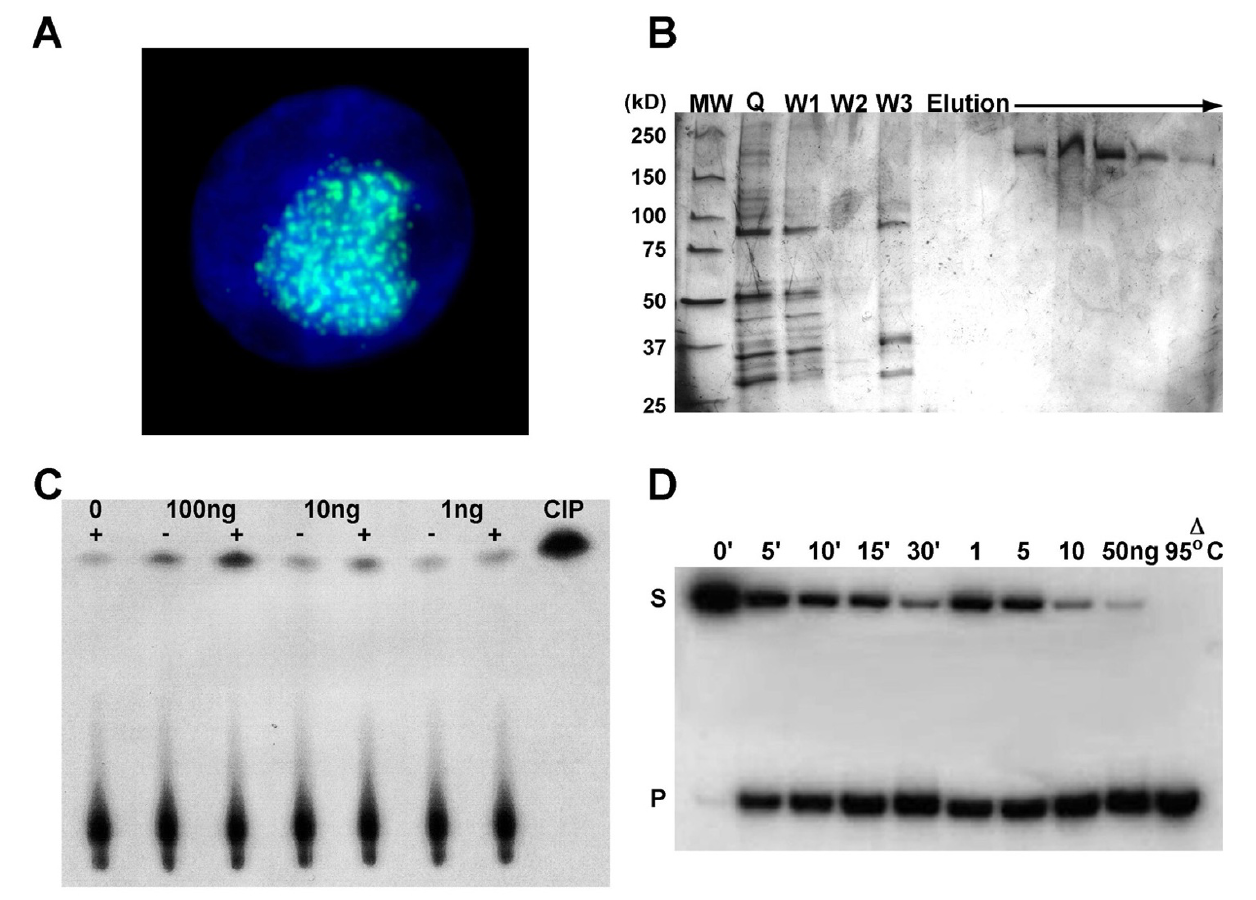
Figure 1 Purification and Assay of GFP-BLM. A. Fluorescent microscope image of GFP-BLM in the DAPI-stained nucleus of an Sf9 cell 72 hours after infection with a recombinant baculovirus. GFP-BLM forms large green aggregates. B. Silver-stained SDS 4- 12% polyacrylamide gel of the purification of GFP-BLM using Macroprep Q ion exchange chromatography followed by metal chelate resin chromatography. Lane Q shows the ion exchange column pool of the green GFP-BLM fractions and lanes W1- W3 are proteins eluted from the metal resin with increasing imidazole washes (wash1 = 10 mM, wash2 = 50 mM, wash3 = 100 mM). The elution lanes show purified GFP-BLM eluted with a final step of 200 mM imidazole. The molecular weights (MW) of the standard markers (BioRad Precision) are indicated. C. Autoradiogram of a thin-layer plate ATPase assay of GFP-BLM. The amount of protein in the assay is shown. The addition of single-stranded Mpl8 DNA is indicated. Calf intestinal phosphatase (CIP) is used as a positive control for [ γ - 32 P]ATP hydrolysis. D. Unwinding of a 32 P-labeled 54 base oligonucleotide annealed to Mpl8 DNA by GFP-BLM. The position of the substrate (S) and the product (P) on the autoradiogram of a 10% polyacrylamide gel are indicated. The gel shows reactions containing 25 ng of GFP-BLM incubated for increasing time at 27 ° C and unwinding by increasing amounts of GFP-BLM incubated at 27 ° C for 30